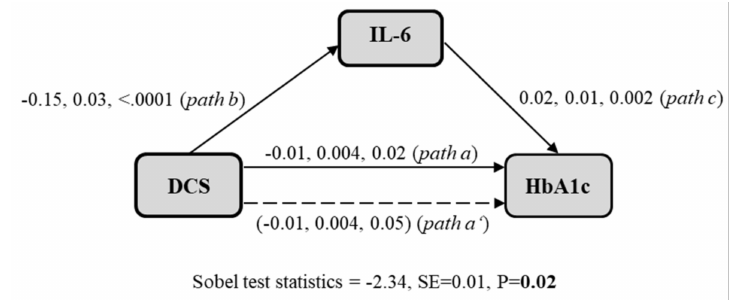
Figure 3. Mediation analysis of chronic inflammation (measured by interleukin-6, IL-6) on the association between diurnal cortisol slope (DCS) and glycaemia (HbA1c). Graphical representation of the mediation analysis: Path a probes the relationship between diurnal cortisol slope (DCS) and glycated haemoglobin (HbA1c) levels. Path b probes the relationship between Interleukin-6 (IL-6) and HbA1c levels, while controlling for cortisol measurements. Path c probes the relationship between DCS and HbA1c. Path c’ probes the relationship between DCS and HbA1c, while controlling for the IL-6 level. The Sobel test was used to test the significance of the mediation effect of IL-6 on the association between DCS and HbA1c levels in age and sex-adjusted regression analyses. Beta estimates with standard deviations and p -values are reported for each association examined. The values in parentheses indicate the effect of cortisol on HbA1c when IL-6 is entered into the